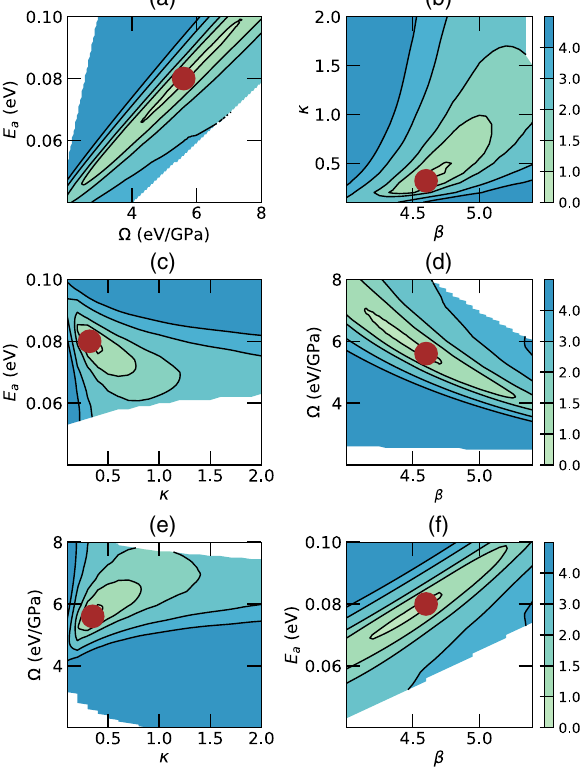
FIG. 9. The LSQ fit measure Q [see Eq. (B1)] as a function of (a) Ω and E a , (b) β and κ , (c) κ and E a , (d) β and Ω , (e) κ and Ω , and (f) β and E a . In each graph, the two remaining parameters of the set ( E a , Ω , κ , β ) are held at their nominal values. The circle shows the location of the nominal parameter set in the phase